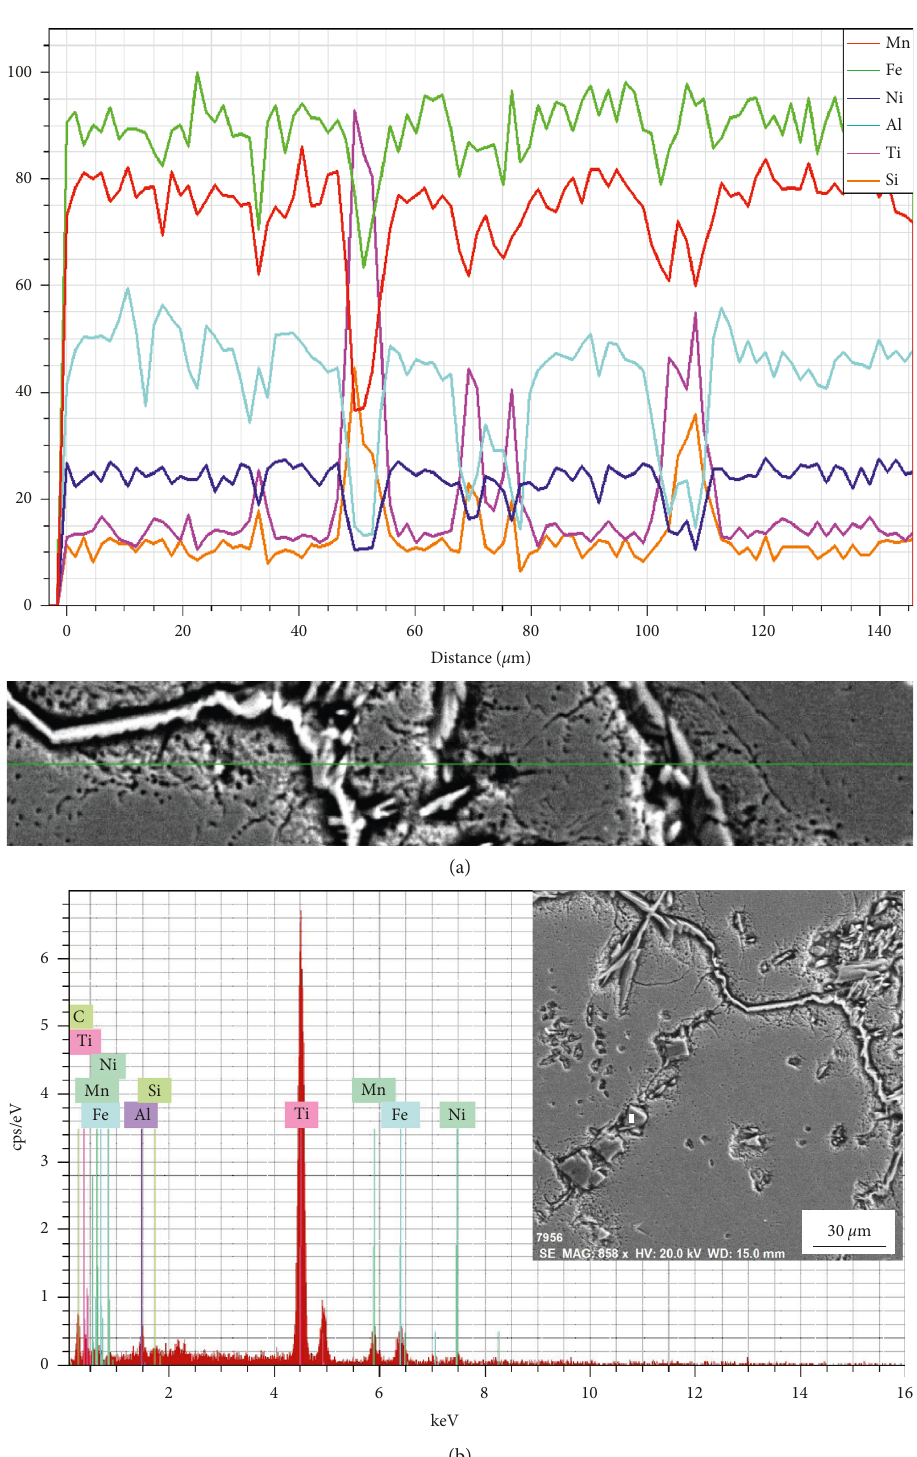
Figure 7: EDX line scan and a point analysis on some grain boundary precipitates in the C3 sample at 30mm